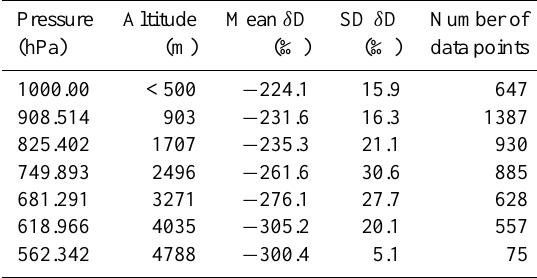
Table 2. Aircraft measurement statistics of atmospheric water vapor δ D variability over the Alaskan interior boreal forest. The data are binned by TES pressure level. Aircraft ascent data only are